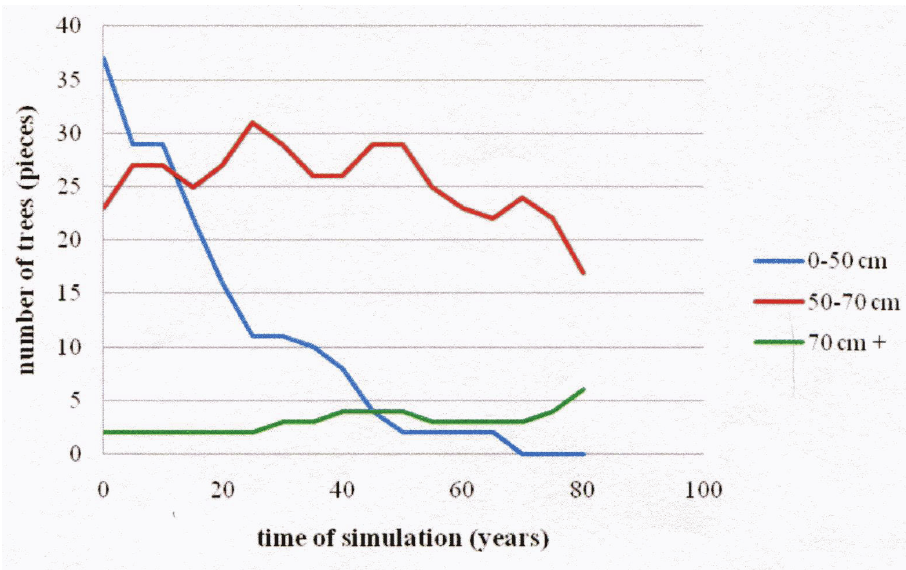
Figure 6. Prediction of time changes in tree diameter diversity (cm) of the beech stands in study site Bucina pod Frantiskovou